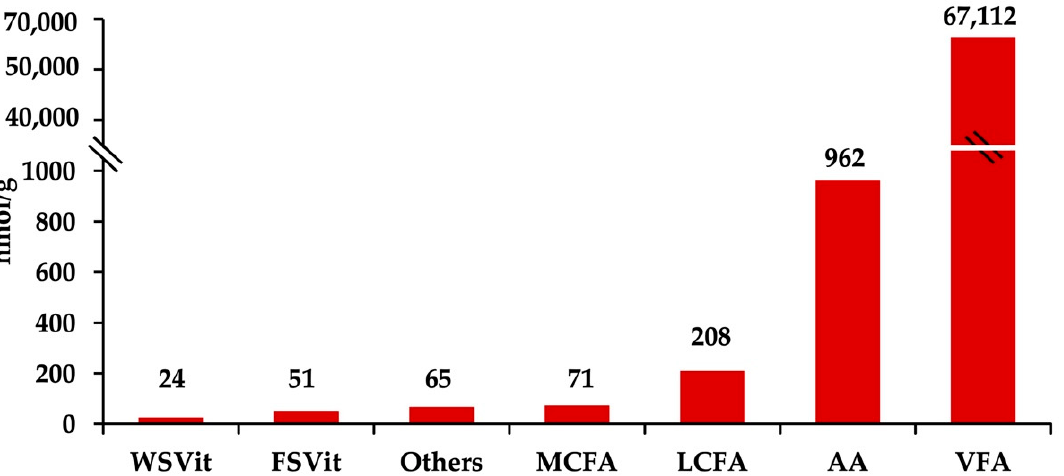
Figure 1. Concentrations of predominant fecal metabolites (nmol/g of fresh feces) in dairy cows across treatments. From right to left: total volatile fatty acids (VFA, <6C), total amino acids (AA), long-chain fatty acids (LCFA, ≥ 16C), medium-chain fatty acids (MCFA, 6C–15C), other metabolites (choline, asymmetric dimethylarginine, taurine, trimethylamine N-oxide, cystathionine, proline-betaine, caffeine, and trigolline), fat-soluble vitamins (FSVit), and water-soluble vitamins (WSVit). Treatments were: (1) heat stress; (2) heat stress with higher vitamin D 3 and Ca (1820 IU/kg and 1.5% Ca); (3) thermoneutral, pair-feeding. Treatments were allocated within two plots differing in basal concentrations of vitamin E and Se (high: 200 IU/kg vit. E and 1.2 mg/kg Se; low: 20 IU/kg